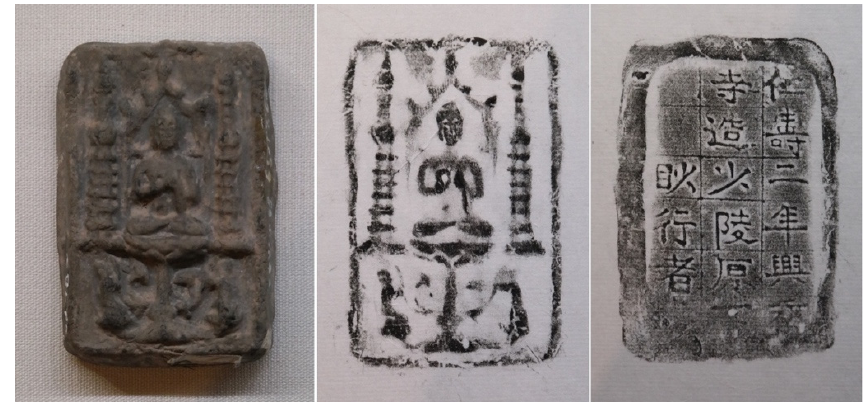
Figure 11. Clay Buddha ( left ), front rubbing ( middle ), and back rubbing ( right ). Sui Dynasty, 602, Xingfu temple, Xi’an, China, Beijing Capital Museum [©Photograph by Lim, 2017].